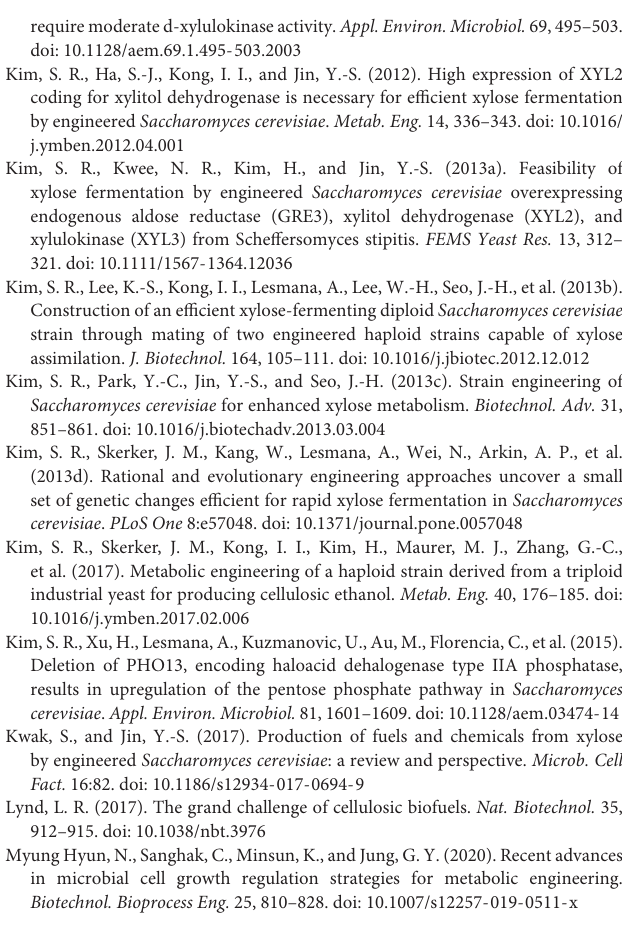
Supplementary Table 1 | SNPs unique to YSX3 relative to